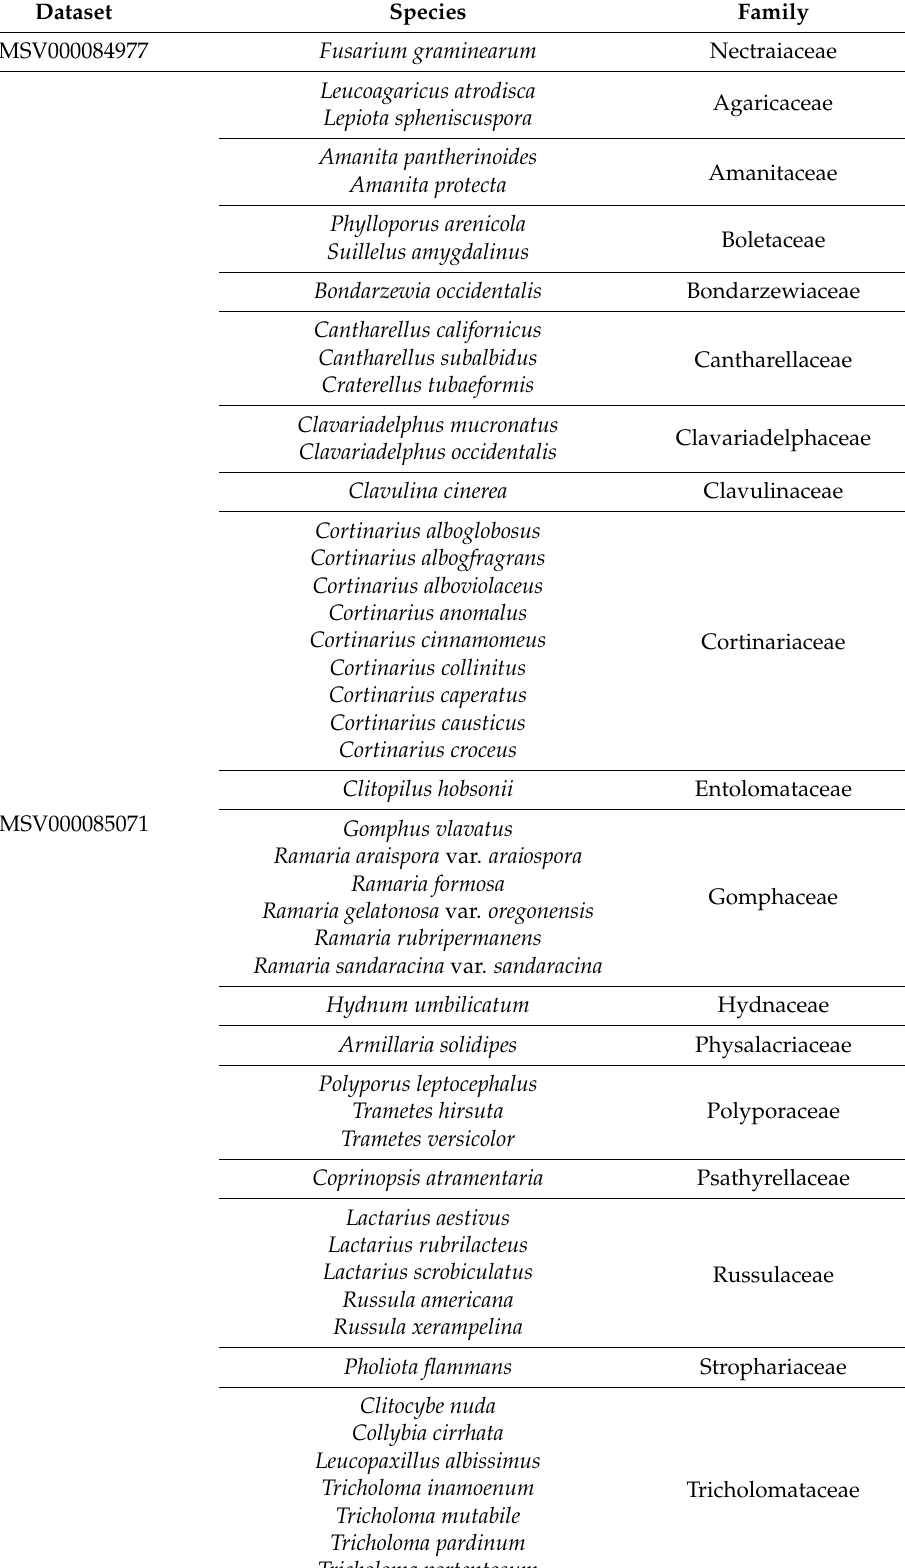
Table 3. Fungal species found to contain compound 1 , according to the MASST